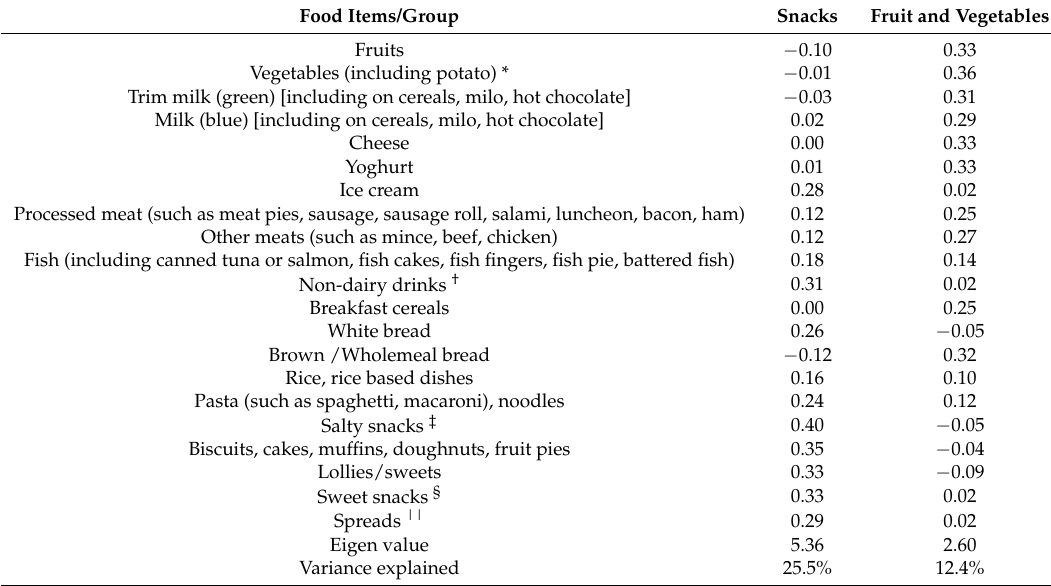
Table 2. Factor loadings (orthogonal varimix rotation) of food items/groups in two identified dietary patterns in 9–11 year-old children in PEDALS.